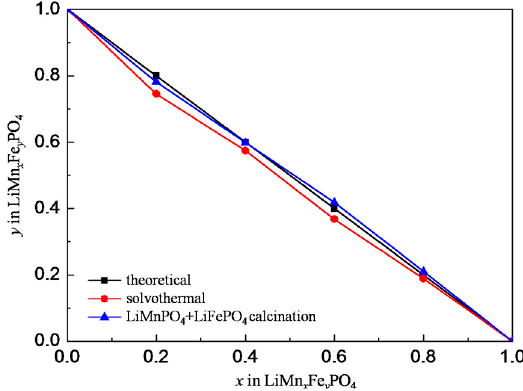
Figure 4. x : y in LiMn x Fe y PO 4 synthesized via different methods.